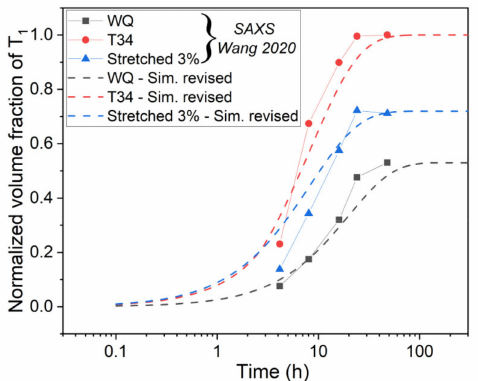
Figure 9. The evolution of the simulated and experimental normalized volume fraction of the T 1 phase during artificial aging at 155 ◦ C with different pre-treatments. The revised model is used for the simulations. Experimental data comes from Wang et al.